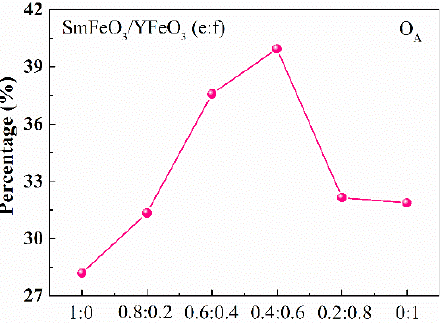
Figure 5. Change trend of the adsorbed oxygen content of SmFeO 3 /YFeO 3 (e:f) nanomaterials.